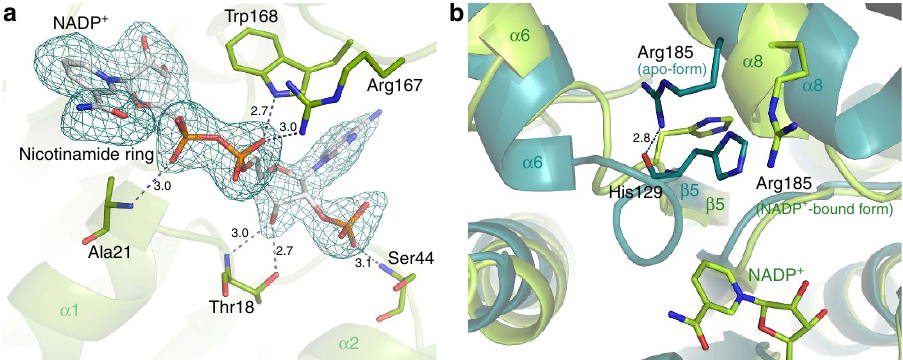
Figure 3 | Electron density map around the bound NADP þ in the Syn BVR. ( a ) An omit F o – F c difference map for NADP þ contoured at 2.0 s (cyan) is overlaid on stick models of Syn BVR and the bound NADP þ . Dashed lines indicate hydrogen bonds, and distances are represented in angstrom units. ( b ) Structural rearrangements in the active site upon NADP þ binding. The structures of the apo-form (teal green) and NADP þ -bound form (light green) are superposed.